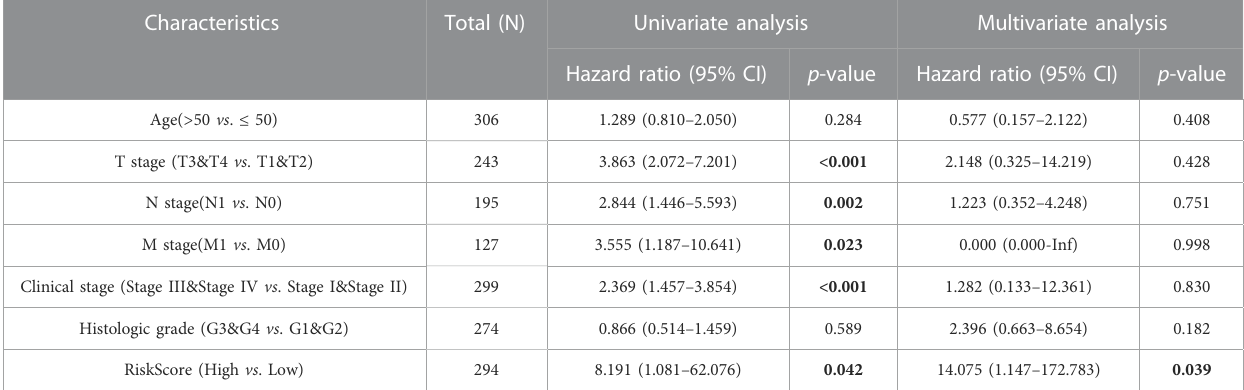
TABLE 2 Univariate/multivariate Cox regression analysis of clinicopathological characteristics of